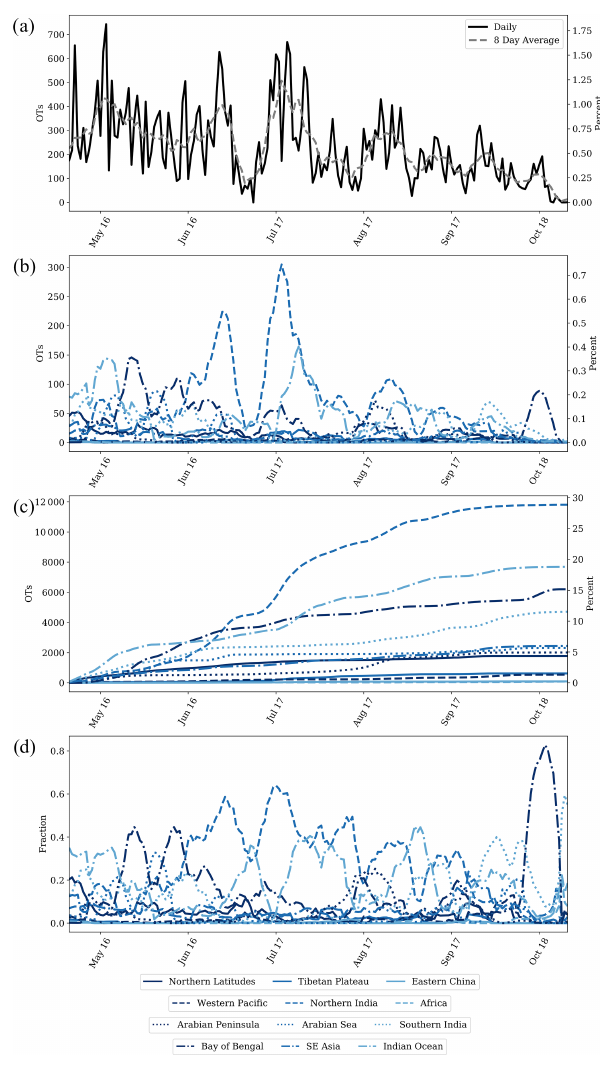
Figure 3. The seasonal development of cross-tropopause convec- tion within the study region. Panel (a) shows the time series of the total daily number (left axis) and percent (right axis) of OTs in black as well as the rolling 8d average in grey (dashed). Panel (b) shows the time series of the daily absolute number (left axis) and percent (right axis) of OTs observed within each region, as indicated by color and line style. Panel (c) shows the cumulative total number (left axis) and percent (right axis) of OTs within each region, as in- dicated by color and line style, as a function of time. Panel (d) shows the daily-normalized fractional contribution of each region, as indi- cated by color and line style, as a function of time.